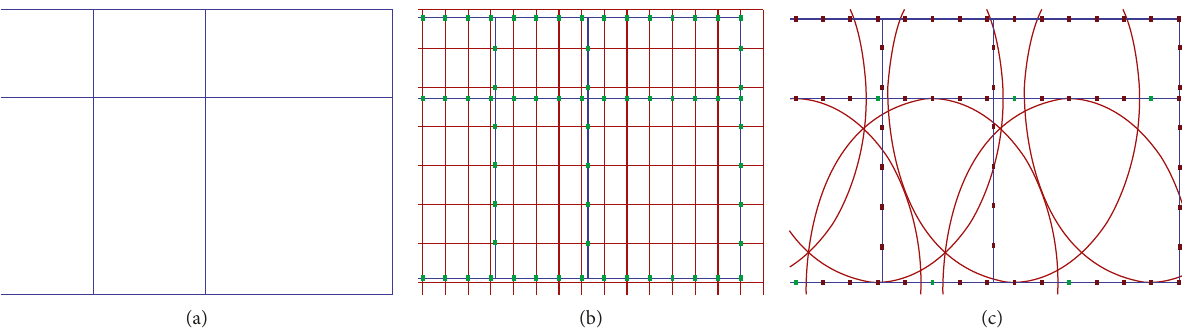
Figure 9: Safety egress algorithm process logics: (a) centerline from the 2D blueprints; (b) grid of 5feet by 5 feet; (c) cull pattern for every five points and circle of 25 feet